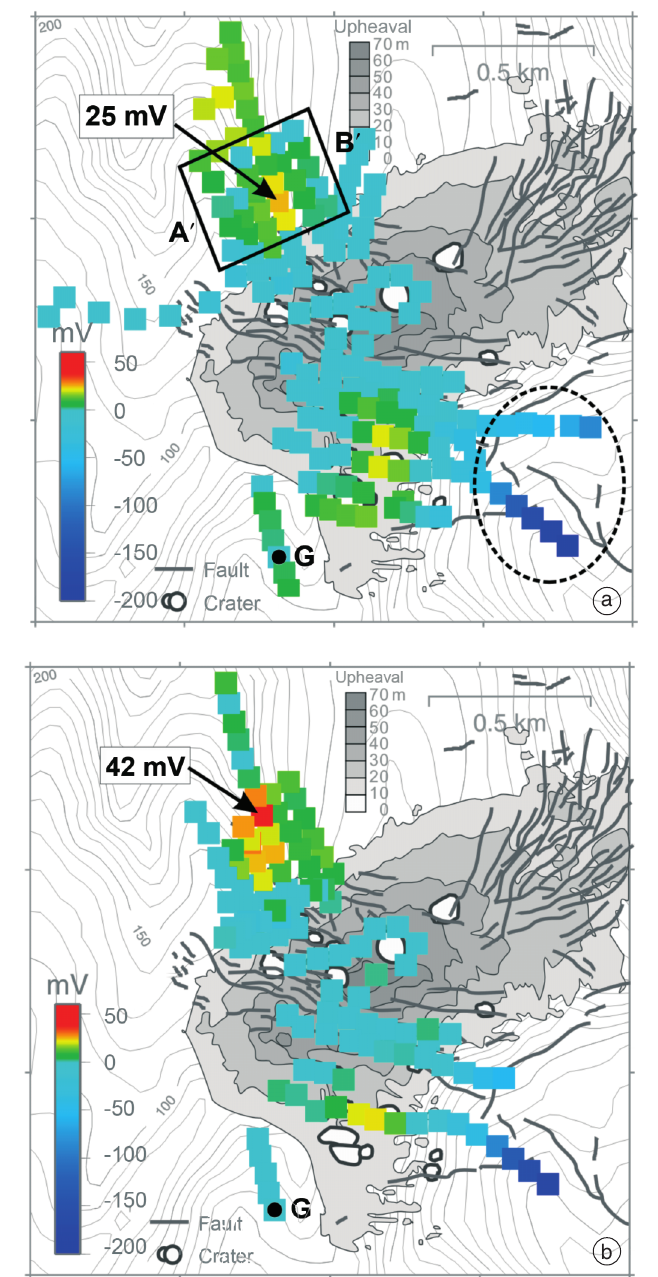
Fig. 6a,b. Temporal variation of self-potential anomalies relative to the reference station G: a) October-Novem- ber, 2000; b) June, 2001.